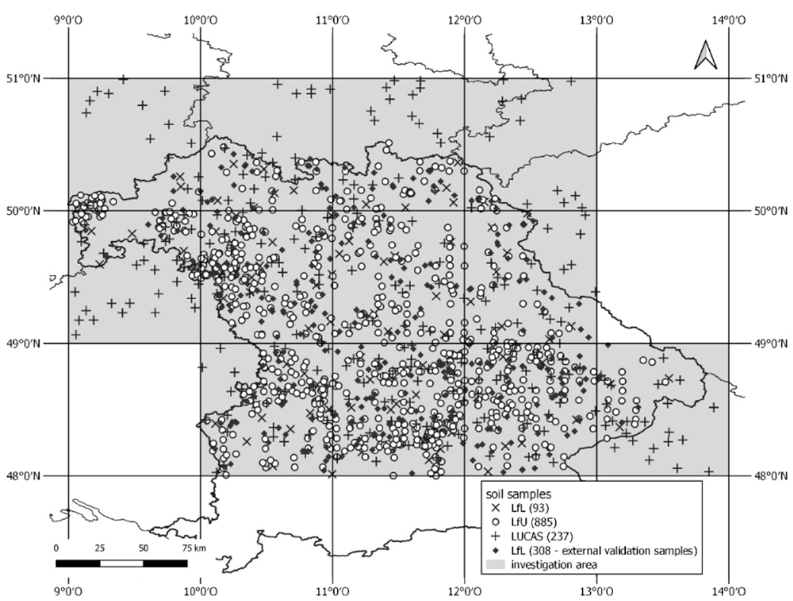
Figure 1. Overview of the study area in Bavaria and the distribution of the soil dataset (LfU— Bavarian Environmental Agency; LfL—Bavarian State Research Center for Agriculture; LUCAS— Land Use/Cover Area frame statistical survey).